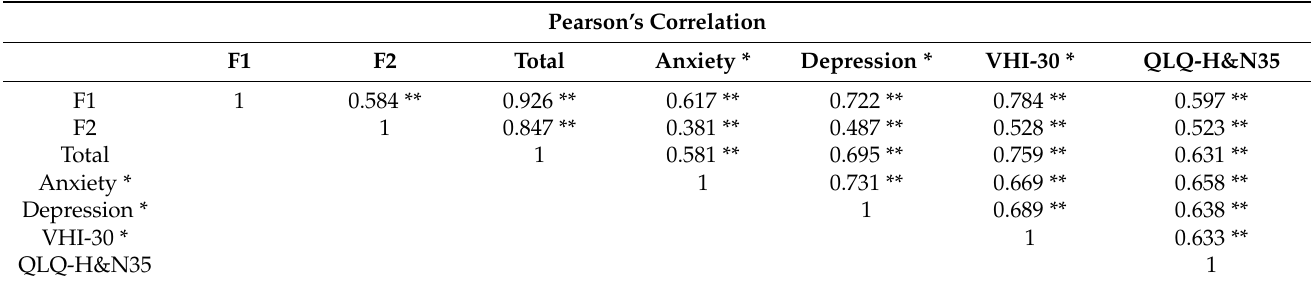
Table 7. Correlation between the factors of the S-SECEL scale (F1, F2 and Total) and the variables of mental health (HADS anxiety and depression), QoL (QLQ-H&N35) and perceived vocal disability (VHI). Pearson’s Correlation F2 Anxiety